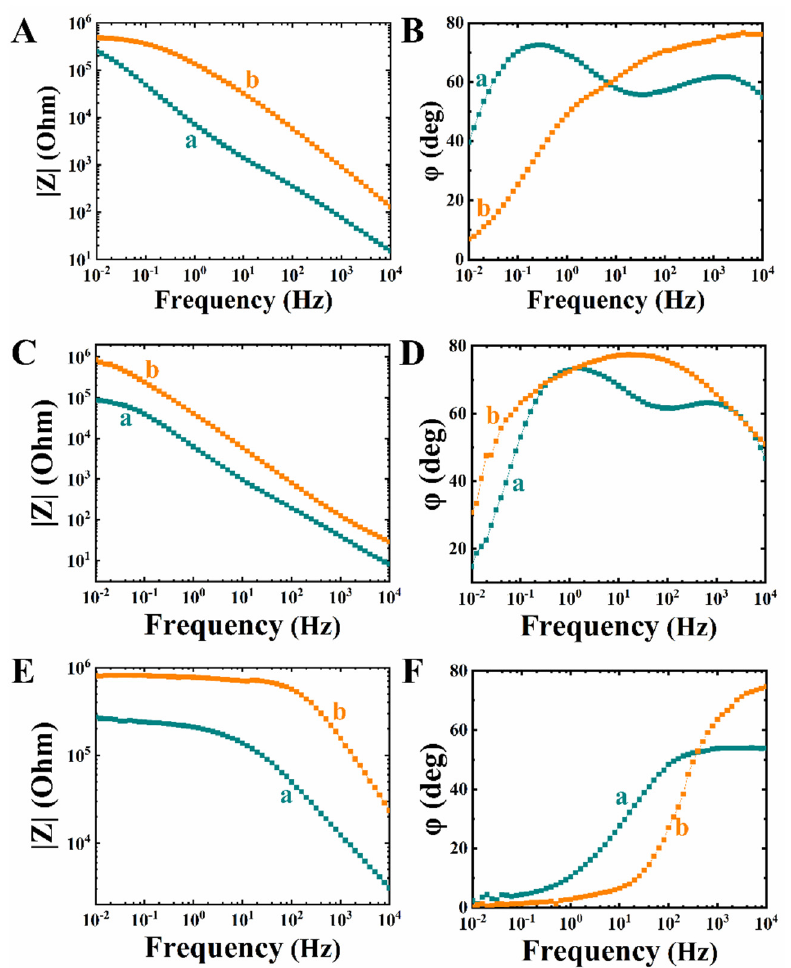
Figure 8. Bode plots for as-deposited (a) monolayer PEMA-FRM coatings and (b) bi-layer composite coatings containing annealed PEMA bottom layer and PEMA-FRM top layer with ( A , B ) huntite, ( C , D ) halloysite, and ( E , F ) hydrotalcite.